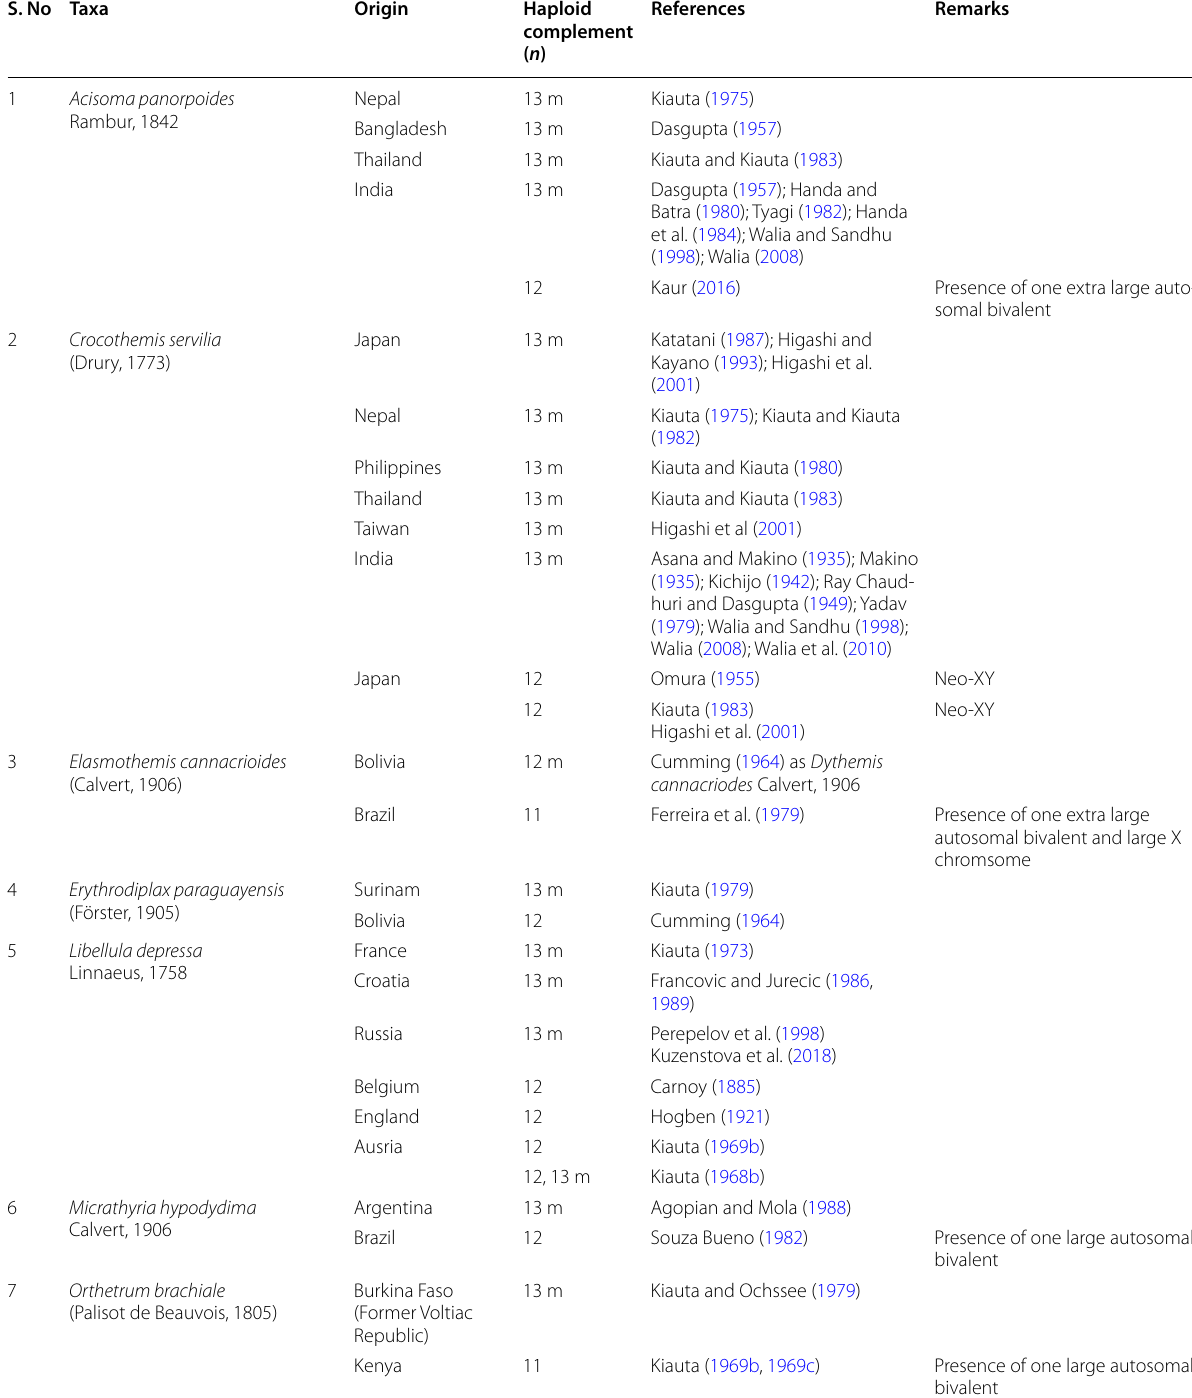
Table 1 Fusion of m chromosome with autosome pair or X chromosome S. No